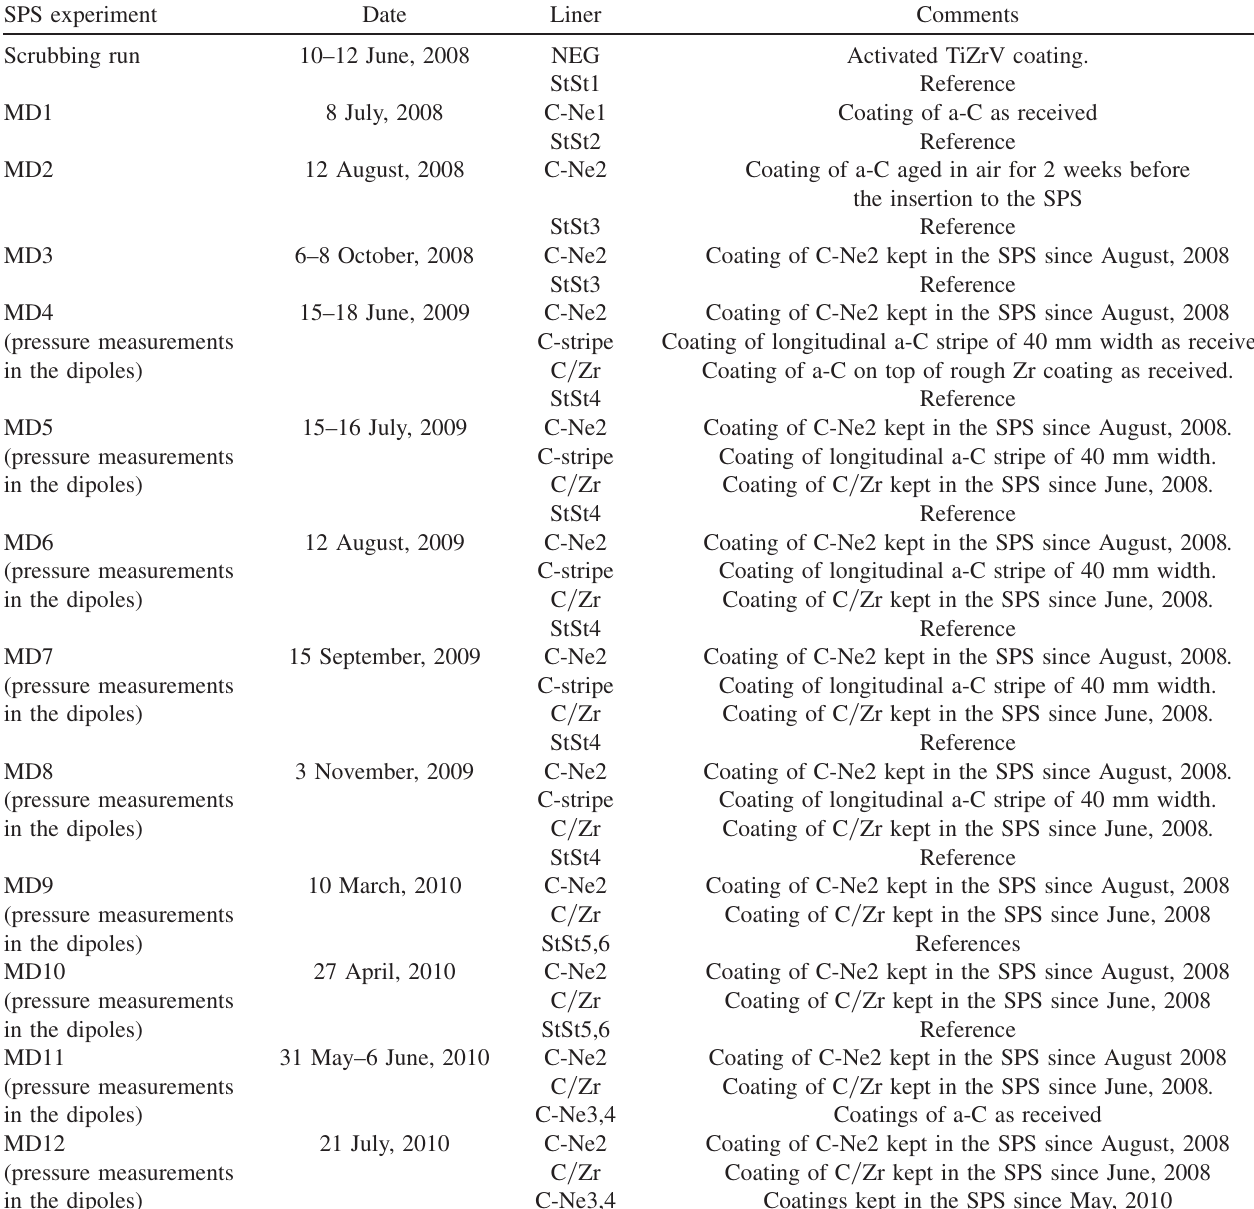
TABLE I. The list of used liners in the SPS